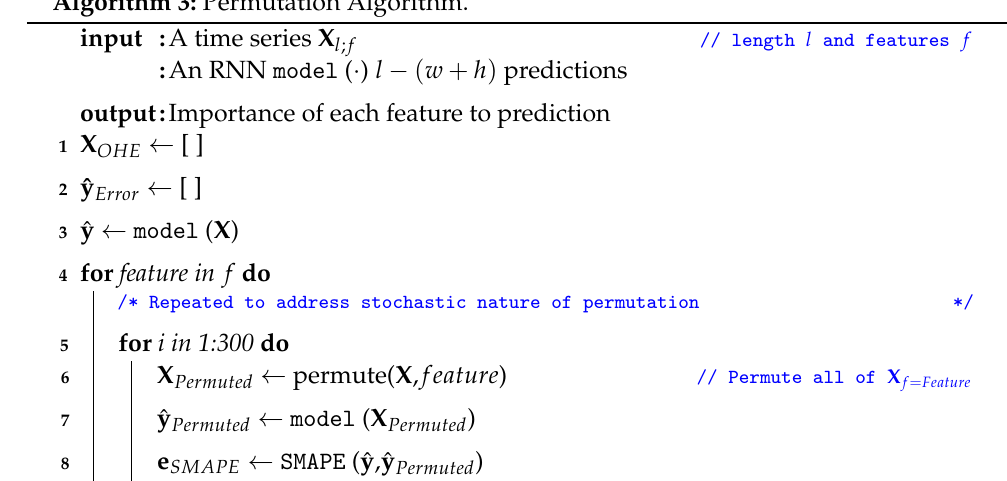
Algorithm 3: Permutation